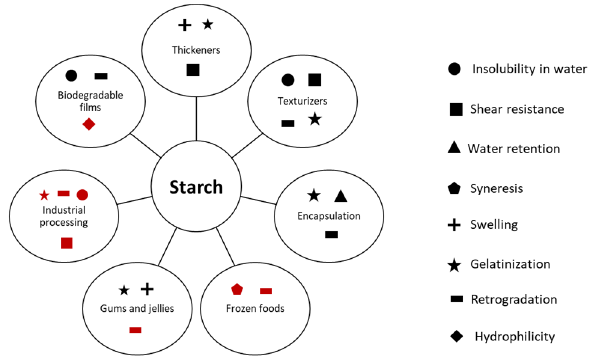
Figure 1. Food-based applications of starch and corresponding properties important for the relative application. Unfavorable characteristics noted in red.